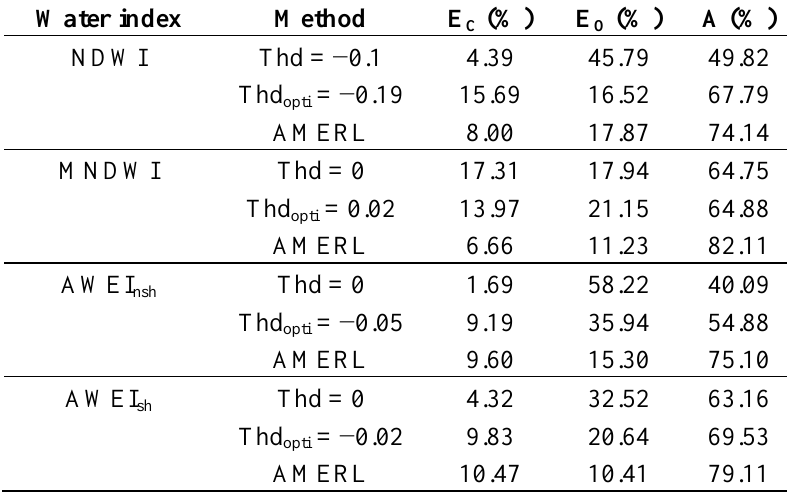
Figure 8. E: errors (C, commission; O, omission); A: accuracy of edge detection.